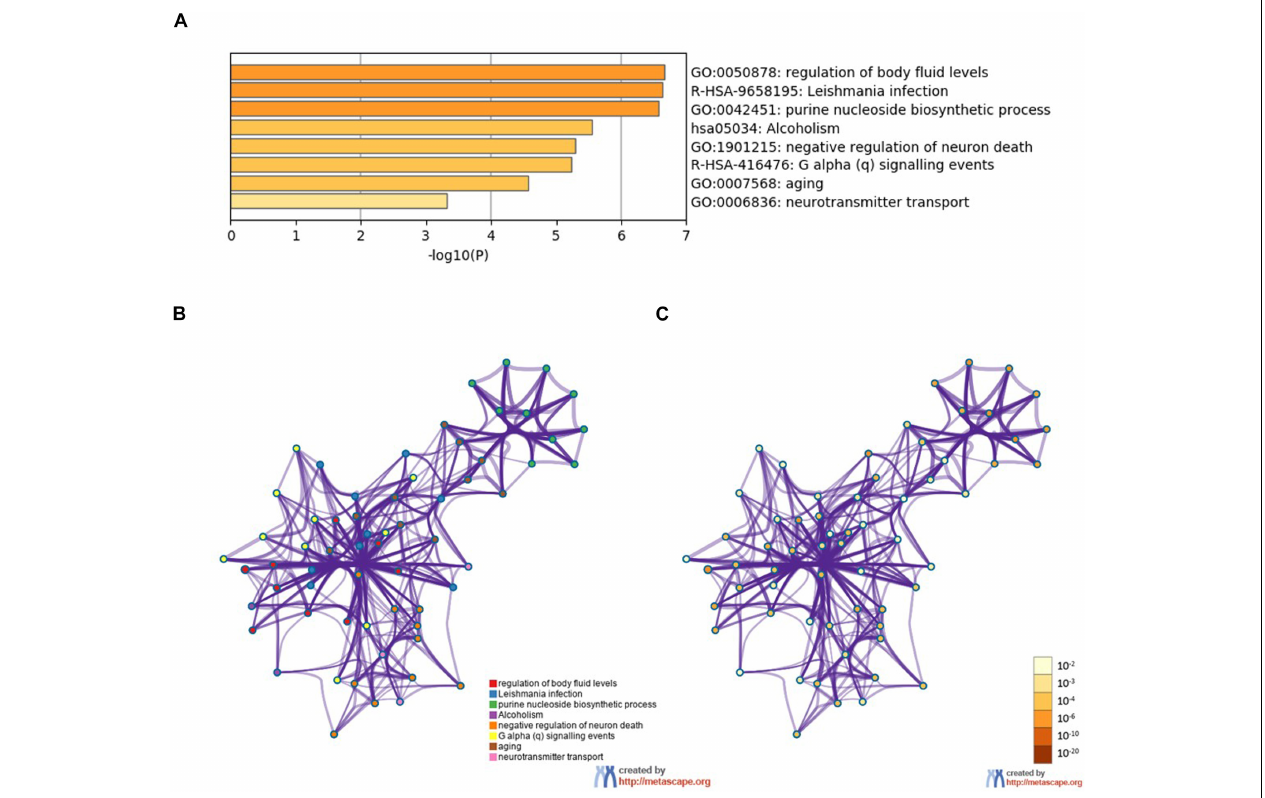
FIGURE 2 | Pathway and process enrichment analysis of the 14 target genes of ADORA2A . (A) The top non-redundant enrichment clusters by Metascape and statistical significance of one per cluster represented by a discrete color scale. (B,C) Metascape visualization of the interactome network. The nodes are colored according to their identities (B) and p -values (C) . Each circle node represents a term, where its size is proportional to the number of input genes falling into that term, and its color represents its cluster identity (nodes of the same color belong to the same cluster). The darker the color, the more statistically significant the node is (see the legend for p -value ranges). Terms with a similarity score > 0.3 are linked by an edge (the thickness of the edge represents the similarity score). The network is visualized with Cytoscape (v3.6.0) with “force-directed” layout and with the edge bundled for